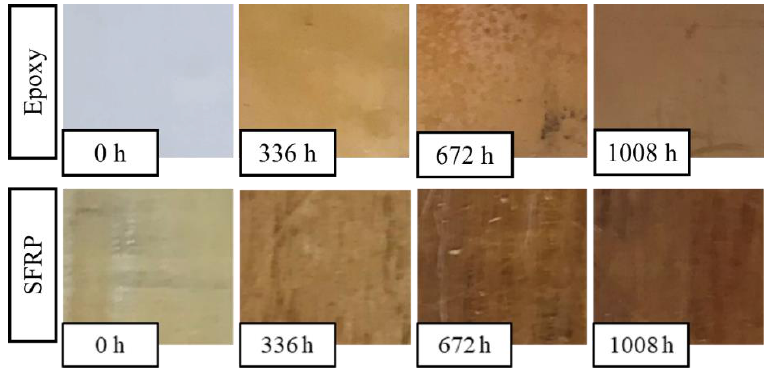
Figure 6. Epoxy and SFRP specimens subjected to different accelerated aging steps.